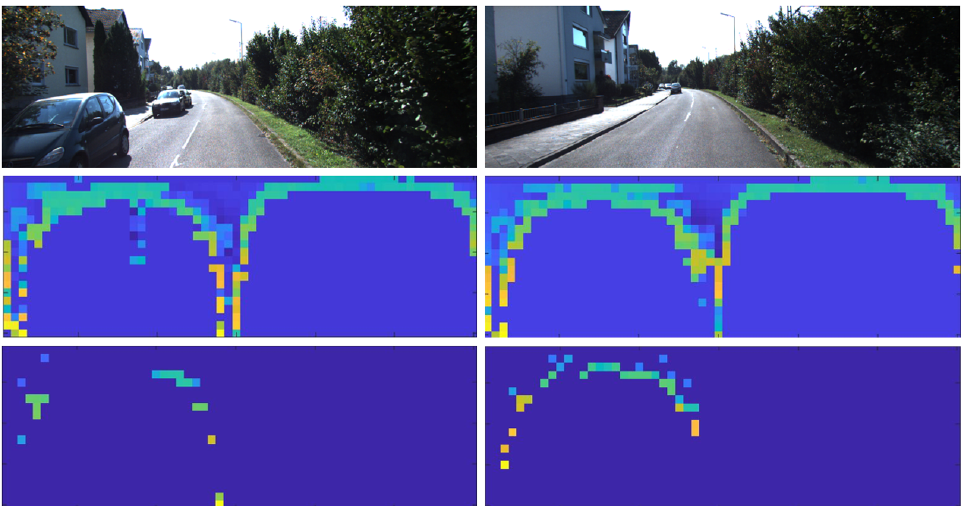
Figure 1. Example of false positive detected by Scan context and triggered by our temporal verification module. Top figures: frame 4058 and 4180 of KITTI sequence 00. The vegetation on the right side makes them difficult to distinguish. Since the ground truth distance between these two frames is 148.64 m, they should not be considered as loop closure. Middle figures: colormap corresponding to scan context before segmentation. Bottom figures: segment scan context of corresponding frame represented by colormap. The left side of colormap indicates the preserved buildings, and the empty right side indicates that the vegetation has been removed. After segmentation, these two frames become distinguishable. If we directly use Scan context, the distance between them is 0.1488, resulting in false positive. Our segment scan context acquires a distance up to 0.327, thus, avoiding